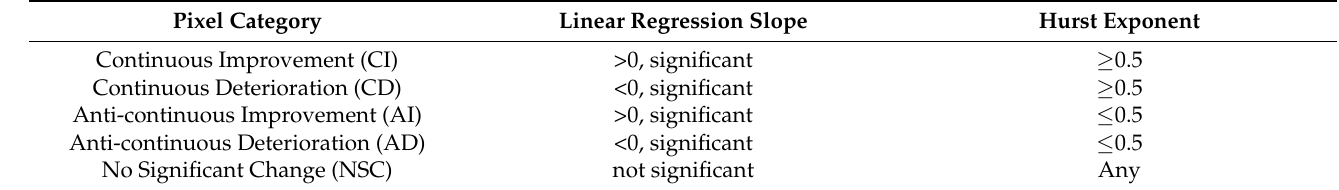
Table 1. Assessment of vegetation greenness change persistence using linear regression results and the Hurst